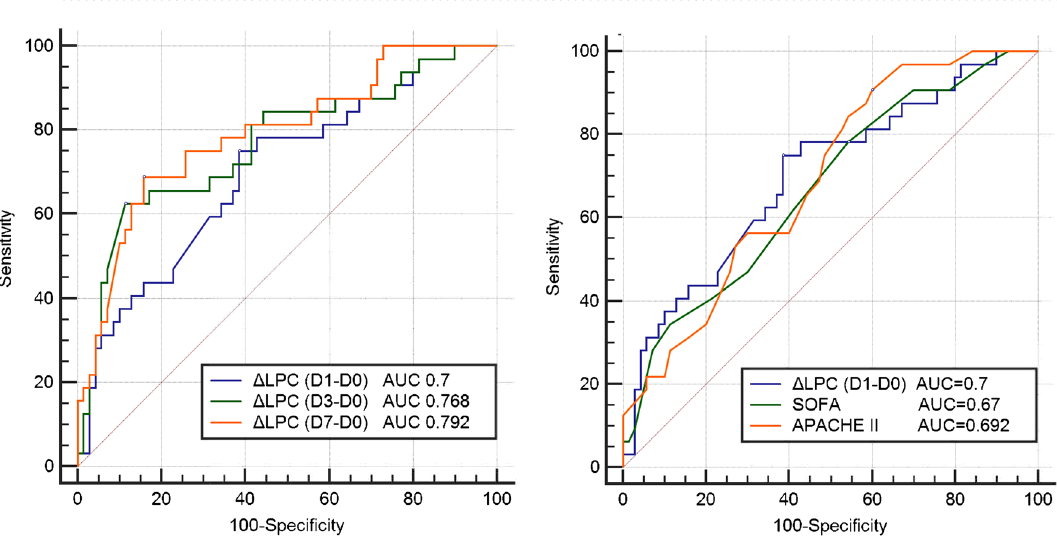
Figure 4. Comparison of Δ LPC16:0 concentration (D1–D0, D3–D0, D7–D0) between survivors and non- survivors in sepsis patients (number of survivors and non-survivors; D0 73:40, D1 73:37, D3 73:28, D7 73:23, respectively), Data provided are the mean ± SEM, *P < 0.05, **P < 0.01, ***P < 0.001 analyzed by Student’s unpaired two-tailed t test.